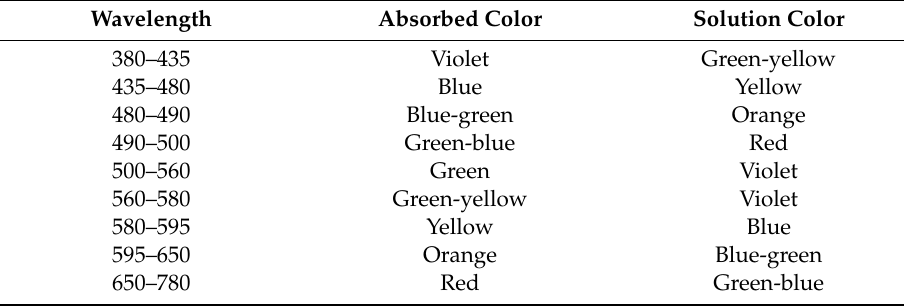
Table 3. Light absorbance for wavelengths in visible spectra.